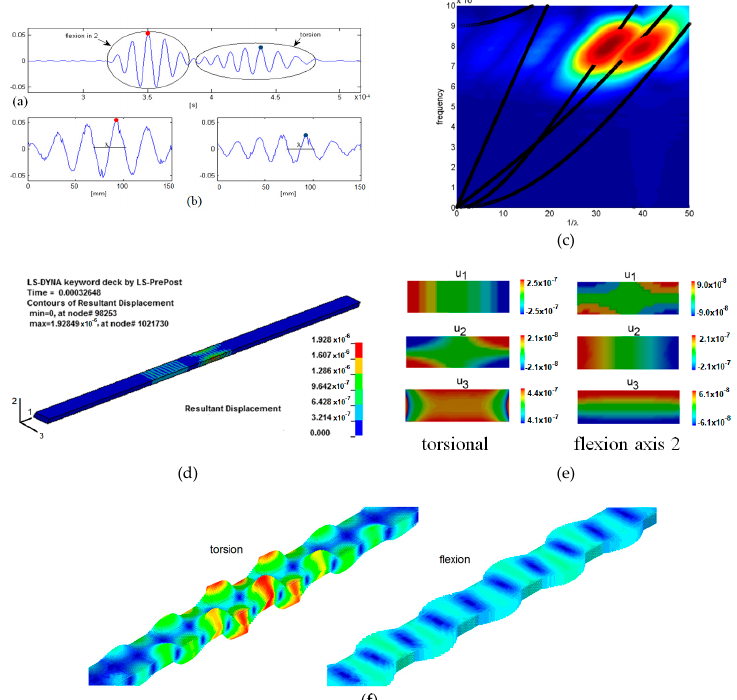
Figure 11: A tone burst with the main frequency of 80 KHz in transversal direction. Experimental results: ( a ) Displacements measured in a point over the scan line where T is the period of each wave propagation mode. ( b ) displacement over the scan line at a specific time. Numerical results: ( c ) amplitude displacement in the frequency vs. wave number dominium (with a black line indicating the dispersion curves). ( d ) Bar analyzed with the map of displacement on it, in a specific time. ( e ) Transversal section with the spatial distribution of two wave modes. ( f ) Tridimensional mode views.